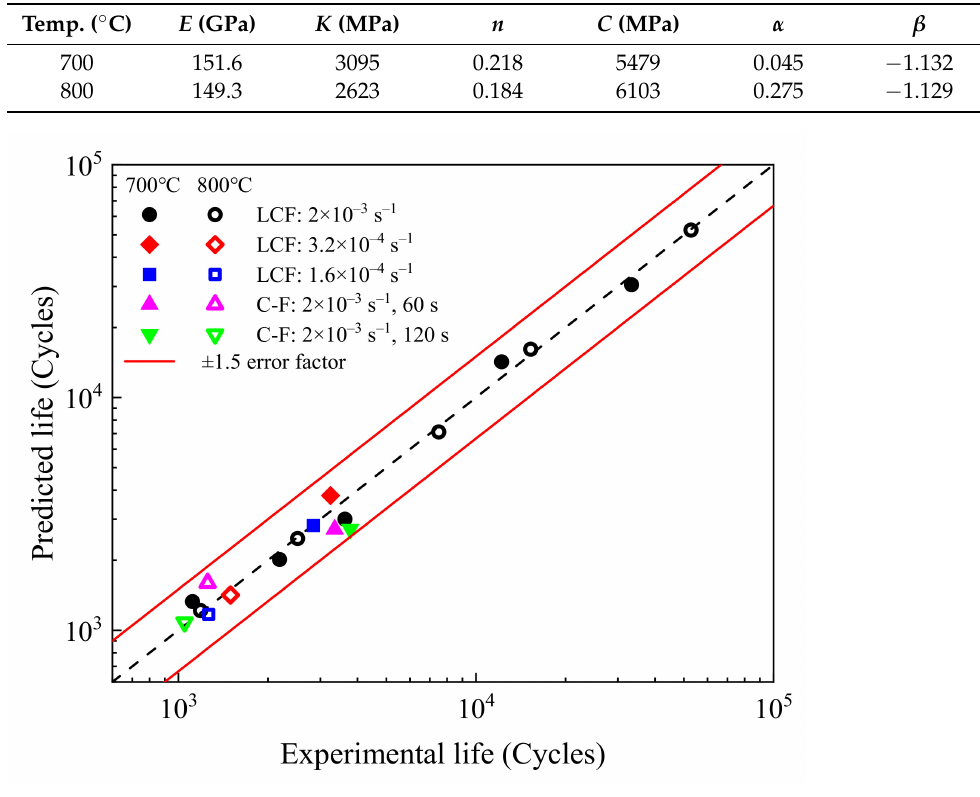
Figure 16. Comparison of predicted and experimental lives of Inconel 625